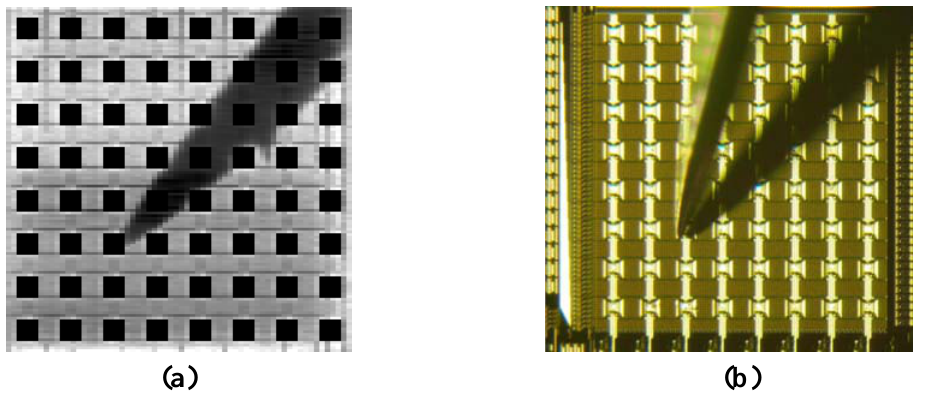
Figure 8. (a) Optical image captured with the dual-image CMOS sensor and (b) experimental situation (adapted from